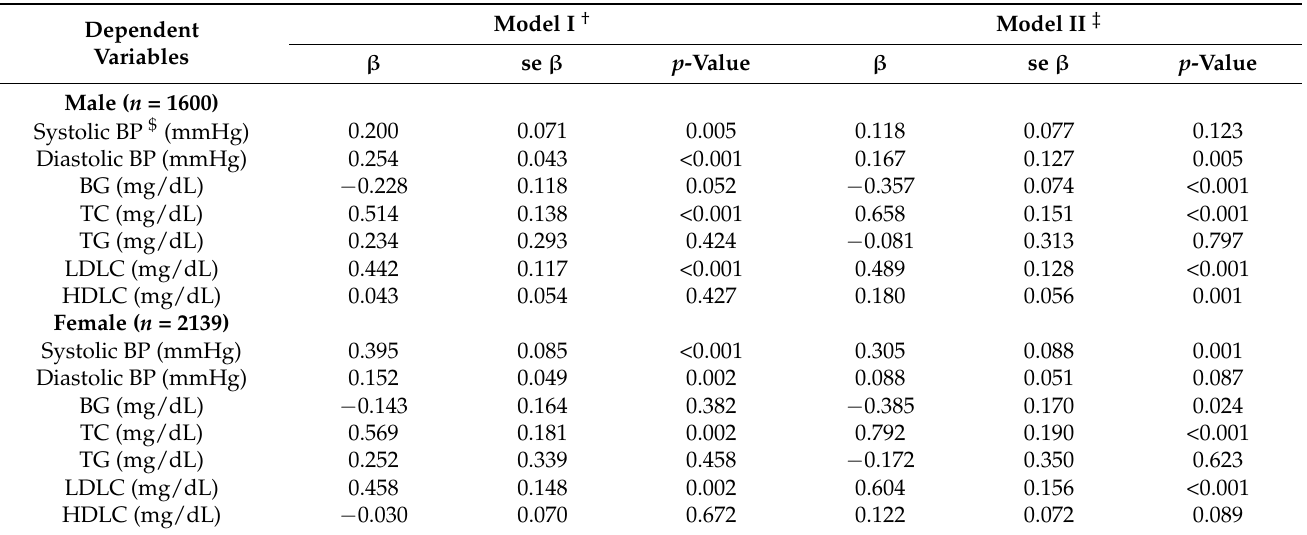
Table 3. Multivariate regression analyses of grip strength on cardiometabolic risk factors in different models with sex specification.